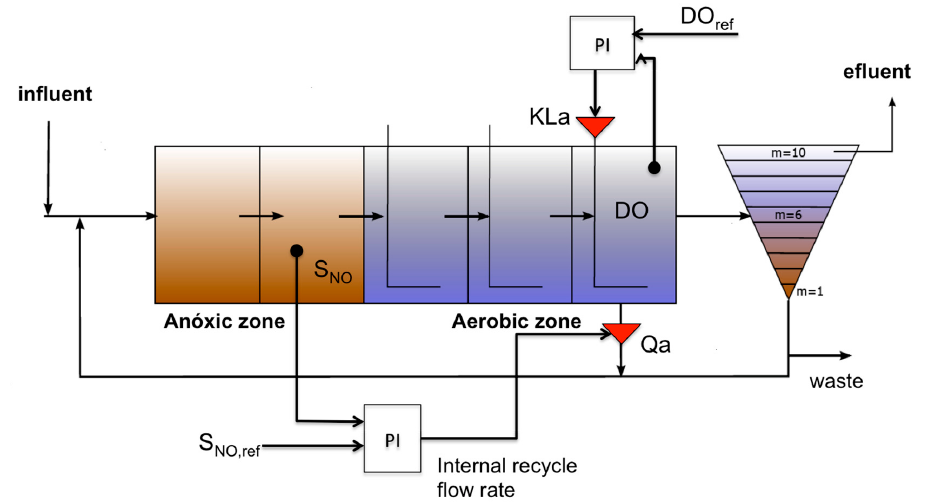
Figure 1. Benchmark simulation model (BSM1) layout indicating the default control strategy. PI: Proportional Integral Controller; DO: Dissolved oxygen.